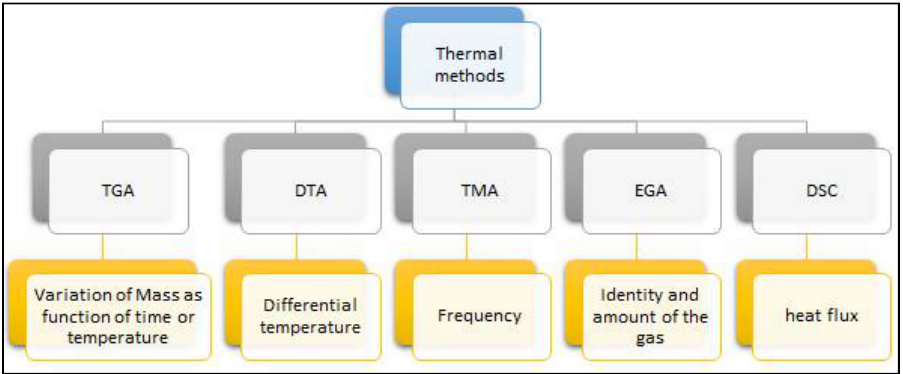
Figure 10. Experimental measurement methods (thermal analysis).